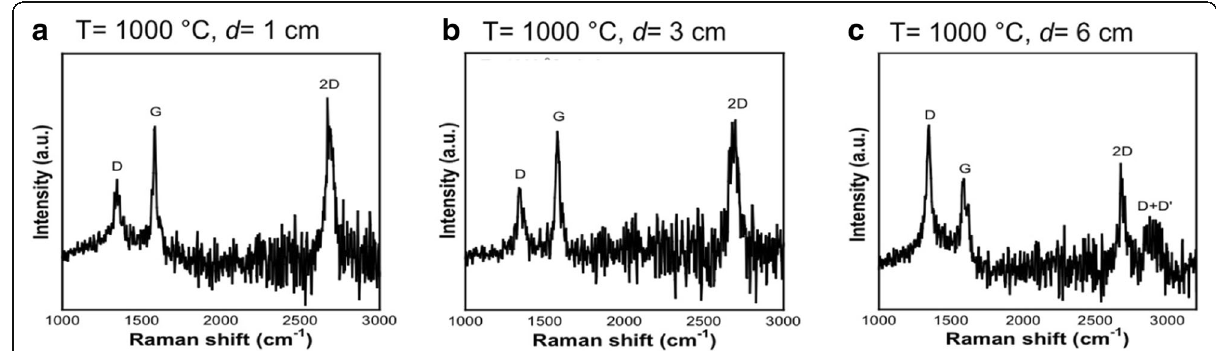
Fig. 4 Single Raman spectrum of graphene on Cu substrate grown at temperature of 1000°C with the distance between a nozzle and a substrate of a 1cm, b 3cm, and c